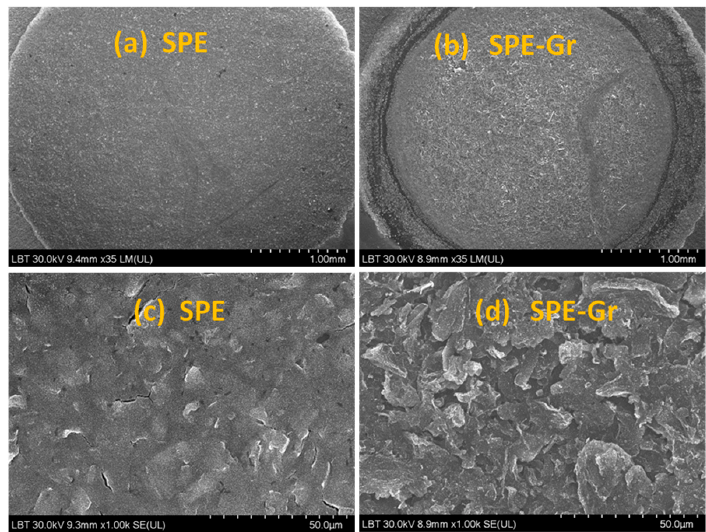
Figure 4. Low- and high-magnification SEM images of SPE ( a , c ) and SPE-Gr ( b , d ); scale bar: 1 mm ( a , b ); 50 μ m ( c, d ).